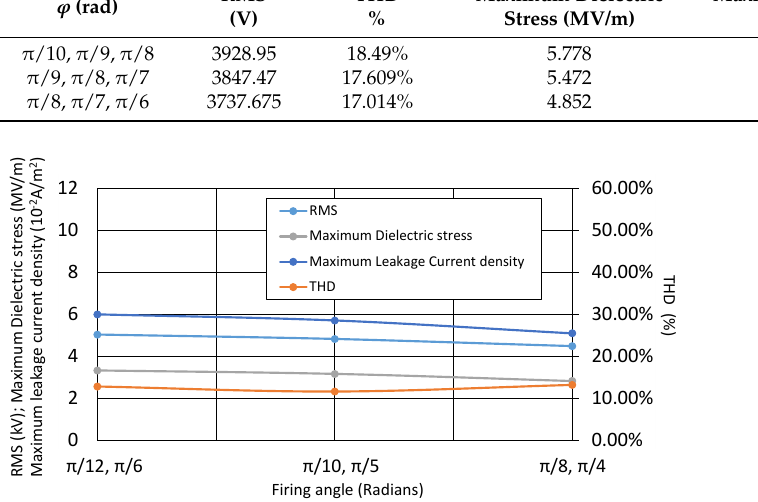
Table 7. Effect of an increase in firing angles for 7-level inverter output.